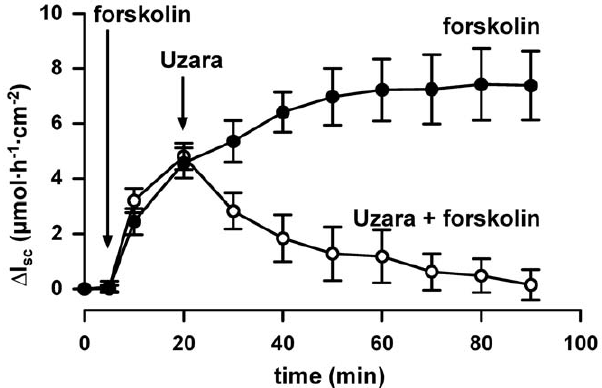
Figure 8. Inhibitory effect of Uzara on the forskolin-mediated I SC rise in human colonbiopsy specimens. Delta I SC ( D I SC ) was determined in human colon mounted in Ussing chambers. Forskolin (10 m M) was added to the basolateral side 15 min prior to basolateral addition of 50 m g/ml Uzara. Also in colonic biopsies, Uzara diminished the forskolin-induced rise in I SC . Data are expressed as mean 6 s.e.m.